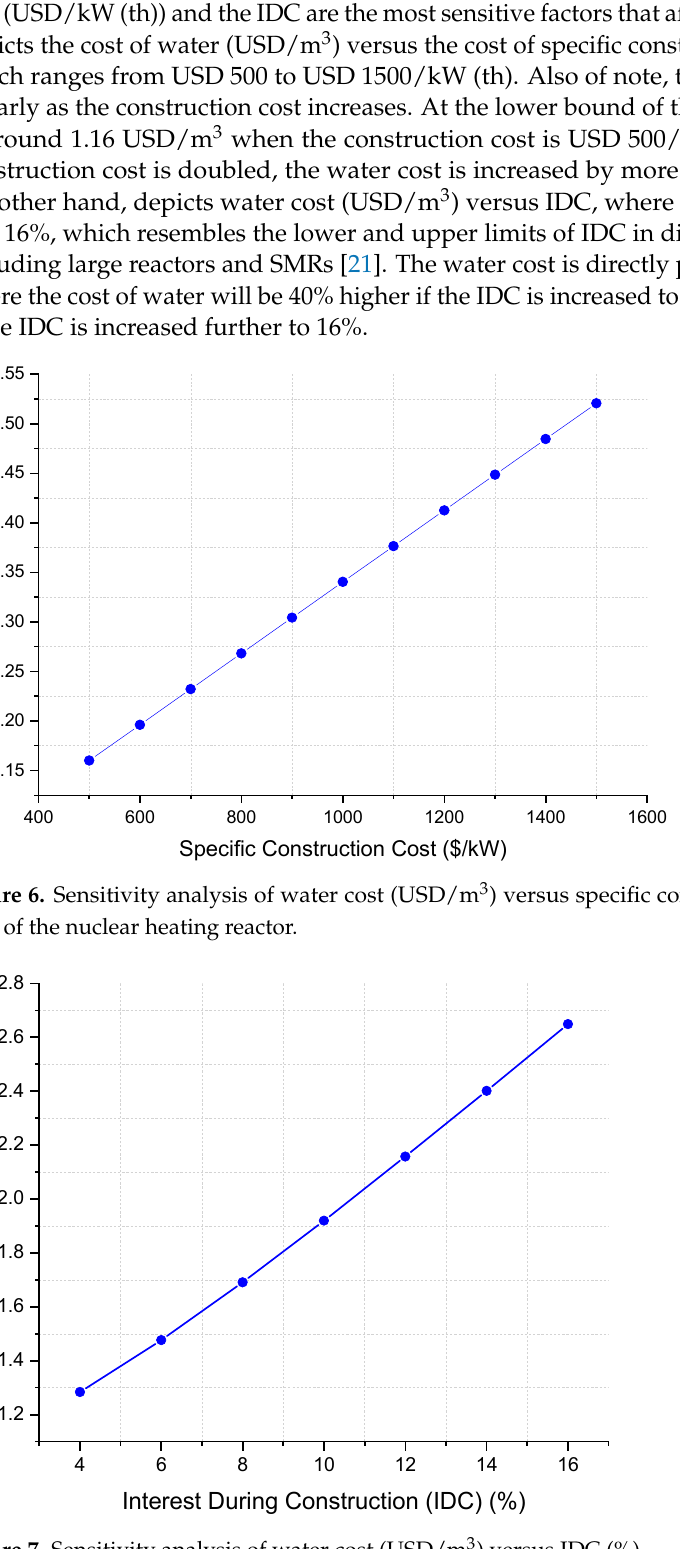
Figure 7. Sensitivity analysis of water cost (USD/m 3 ) versus IDC (%).